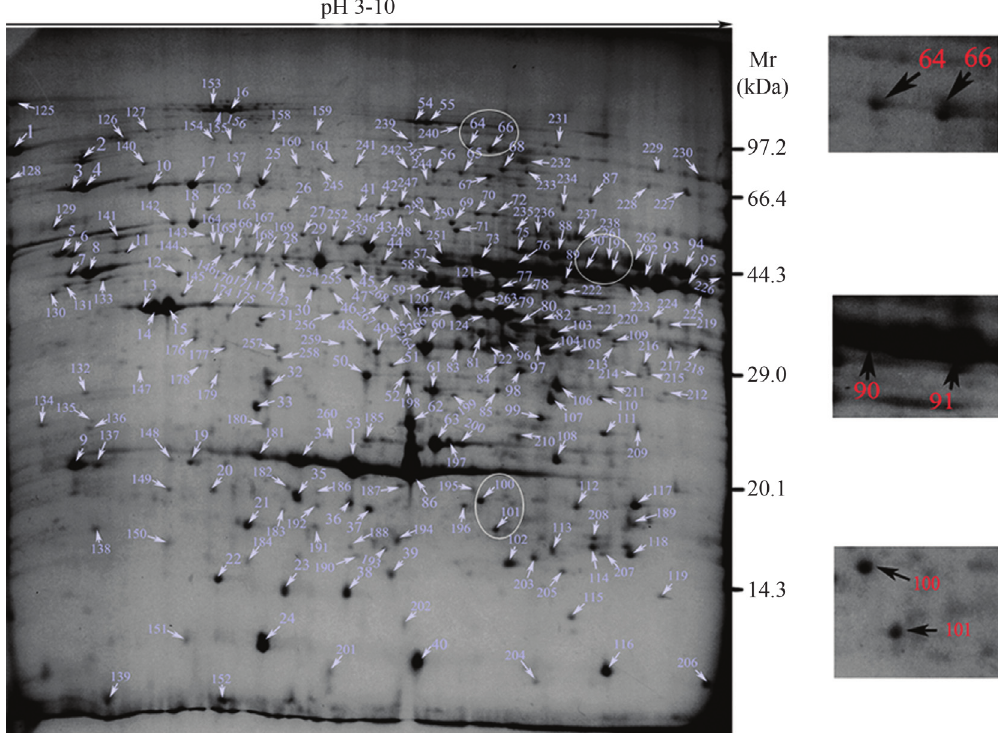
Figure 1 - Two-dimensional electrophoretic reference map of E. taeniura liver. A total of 268 protein spots were observed, of which 109 gave a good MS signal; 84 of the latter proteins were identified in subsequent analysis. A sample of liver protein (1.4 mg) was separated by IEF (linear pH gradient from pH 3-10) and SDS-PAGE on a 12% polyacrylamide gel. Proteins were visualized by coomassie brilliant blue (CBB) G-250 staining. Expanded views of spots 64, 66, 90, 91, 100 and 101 are shown on the